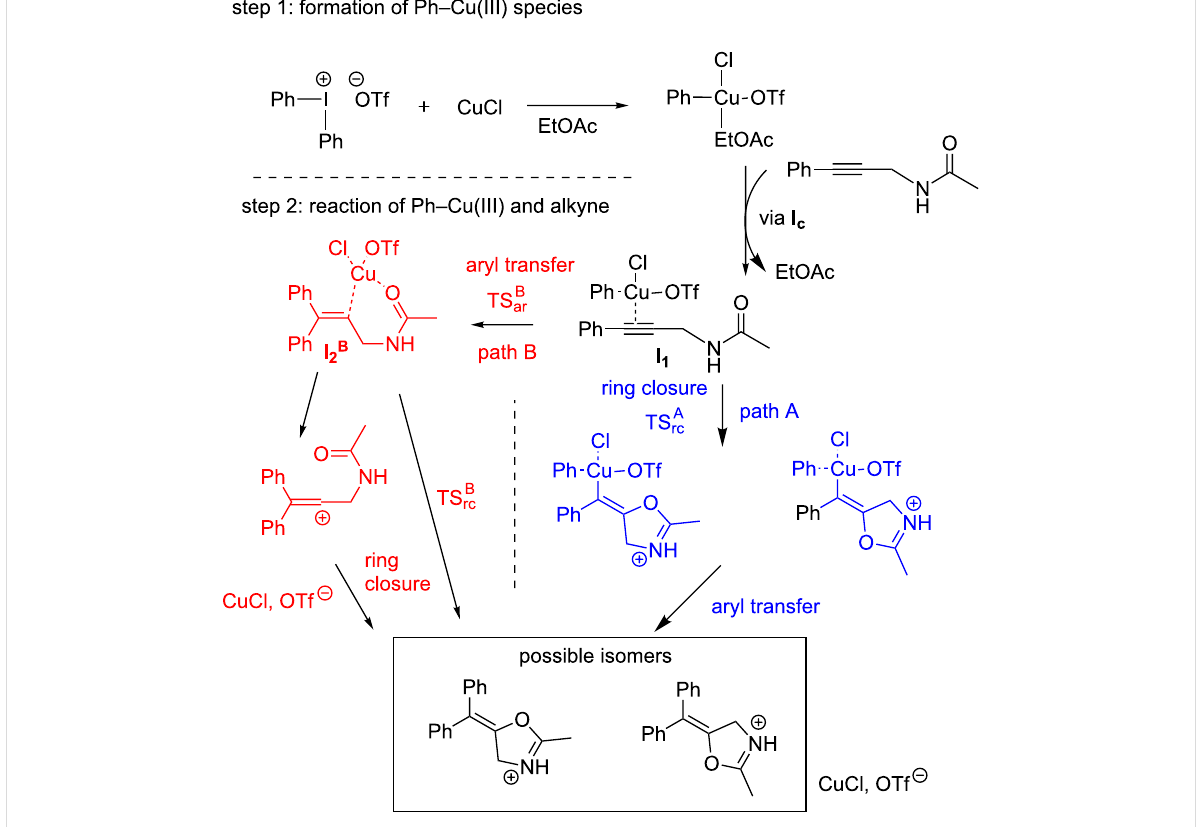
Scheme 2: Two possible reaction routes for the oxazoline formation explored by computations. The schemes indicate the possible stereochemical outcomes. For the definition of the labels of intermediates and transition states see Scheme 3.